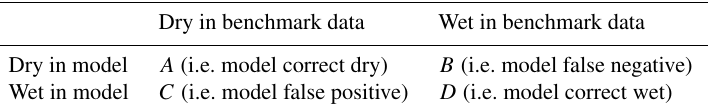
Table 1. Contingency matrix of possible cell descriptors in a binary classification scheme. The four possible states of the matrix are denoted A , B , C and D to simplify their description in Eqs. (1)–(4).